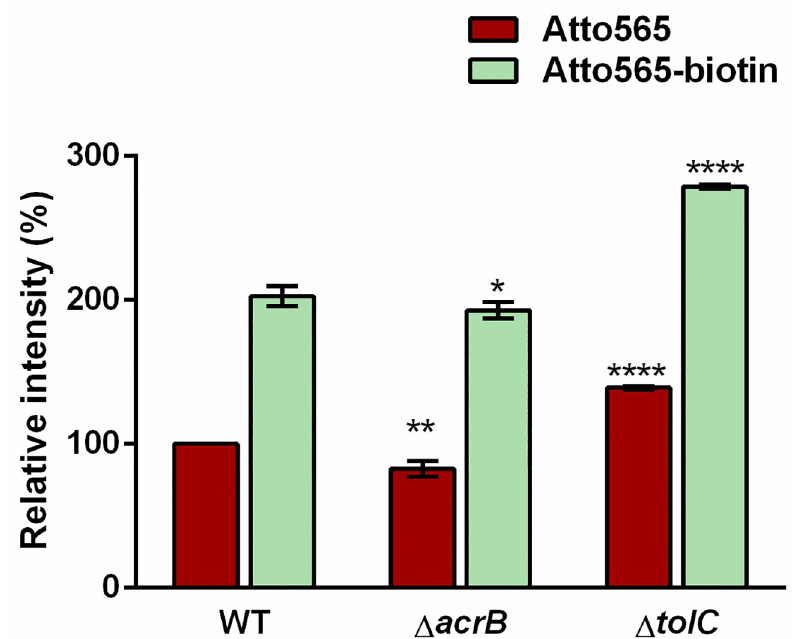
Fig 4. Accumulation of Atto565 and Atto565-biotin in wild type versus efflux knock out BW25113 strains. Figure shows the representative data from three independent experiments. Data were presented as mean ± S.D. (Two- way analysis of variance; ���� p < 0.0001, �� p < 0.01, � p < 0.05). Asterisks above the Atto565 accumulation bar represent significance when compared them with Atto565 accumulation in WT strain, whereas asterisk above the Atto565-biotin accumulation bar represent the significance when compared with Atto565-biotin accumulation in WT